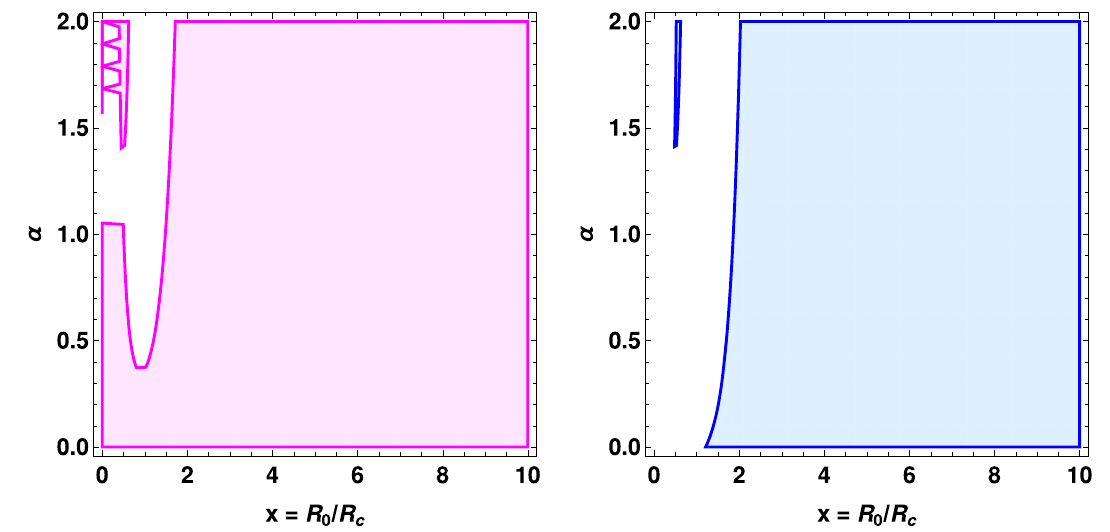
Fig. 10 Stability region of the model (1). Figure on the left side shows the stability region allowed by Eq. (41) and figure on the right side shows the stability region allowed by Eq. (44)